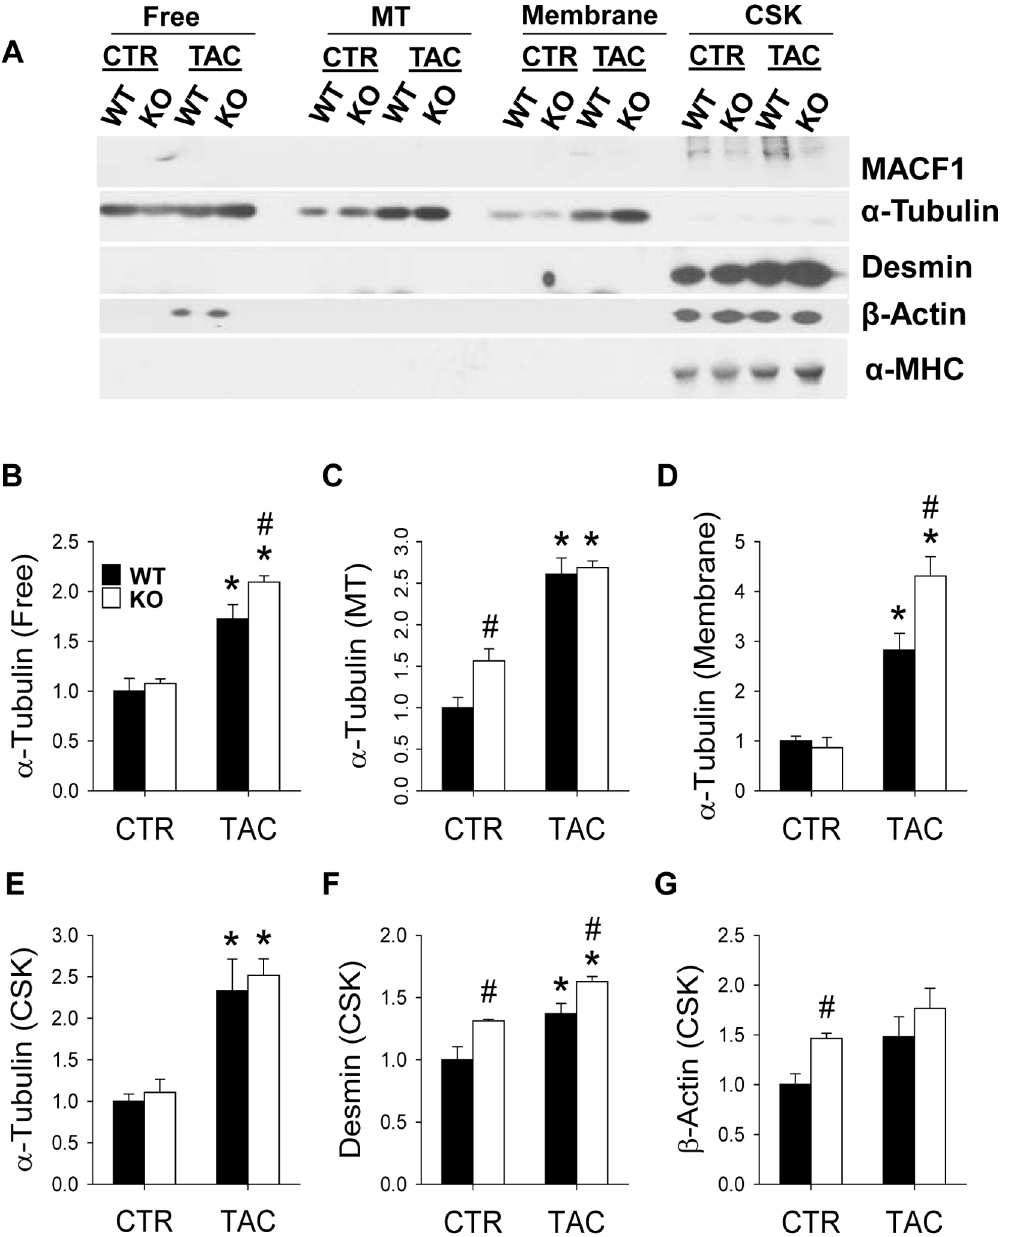
Figure 4. Maladaptive response to pressure overload is associated with redistribution of microtubules into distinct subcellular fractions. LV lysates from WT and MACF1 KO hearts exposed to control or TAC conditions were separated into cytosolic fractions (Free), Microtubule fractions (MT), trition soluble membrane fractions (Membrane), and triton insoluble cytoskeletal fraction(CSK) Equal amounts of fractionated proteins from each sample in a treatment group were pooled and the four different fractions were examined side by side by western blot to measure relative changes in levels and subcellular distribution of MACF1, Tubulin, Desmin and b -Actin (Figure 4A–4G) (* indicates p , .05 as compared to control conditions, # indicates p , .05 as compared to WT under same conditions).